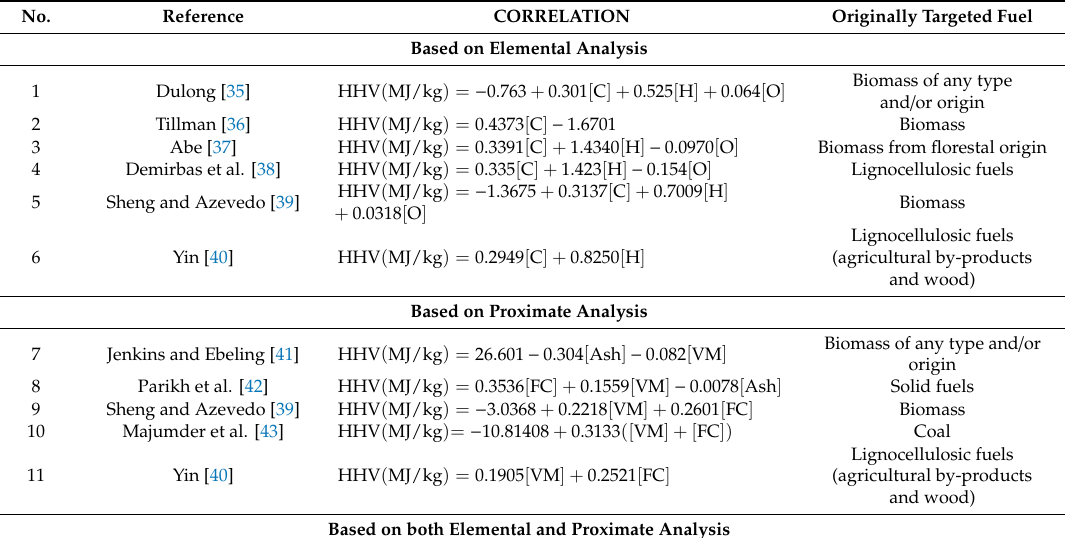
Table 1. Correlations considered for the estimation of the high heating value